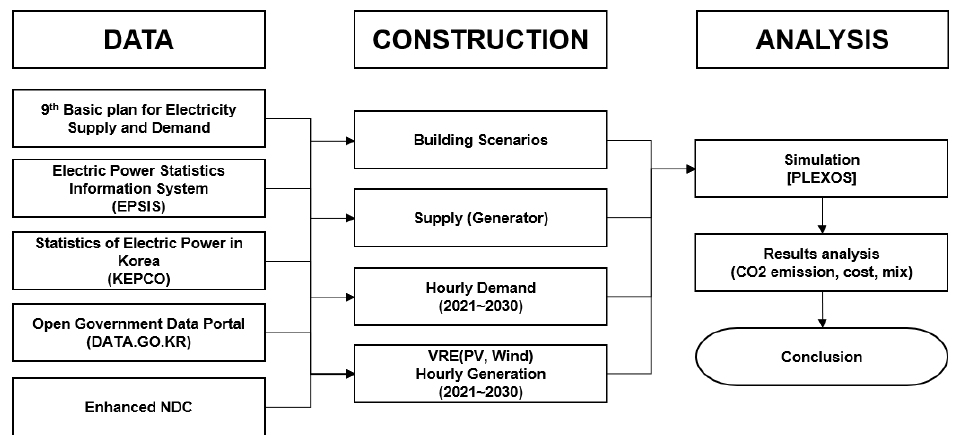
Figure 2. The procedure of data collection and analysis.